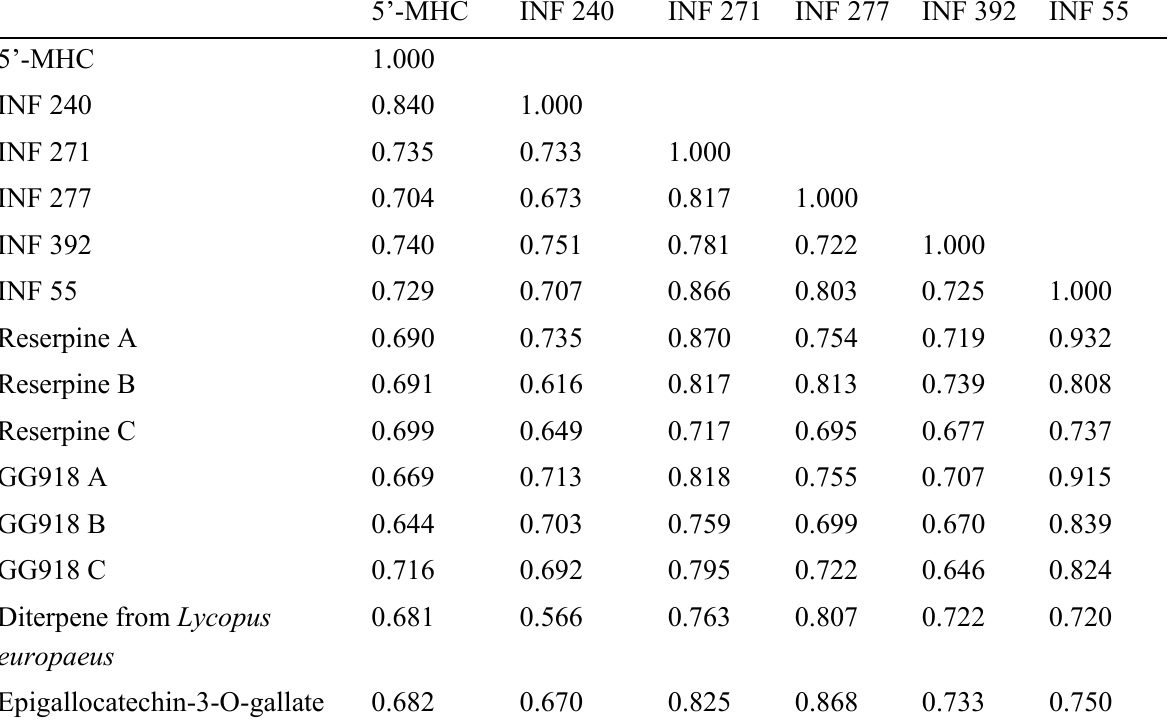
Table 2. Final similarity matrix for MDR inhibitors of the NorA pump calculated by MIPSIM using point charges. Three parts of reserpine were denoted as Reserpine A, Reserpine B and Reserpine C, and three parts of GG918 were denoted as GG918 A, GG918 B, and GG918 C. Similarity between parts that belong to the same molecule were not